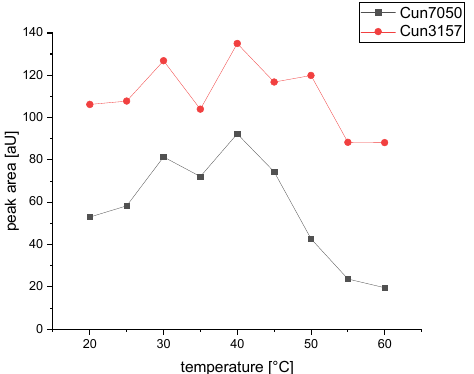
Figure 3. Temperature optimum of Cun3157 and Figure 3 . Temperature optimum of Cun3157 and Cun7050. Figure 3 . Temperature optimum of Cun3157 and Cun7050.